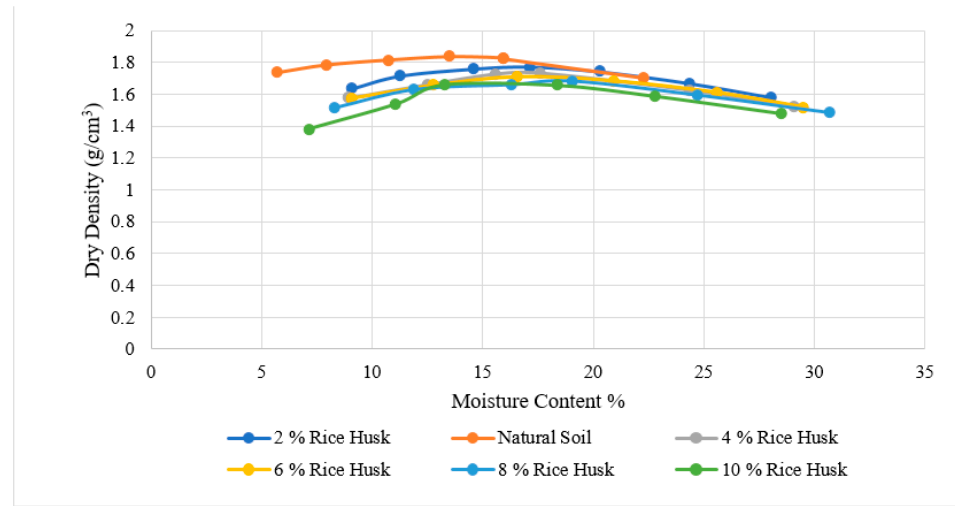
Figure 7. Rice husk Proctor results.